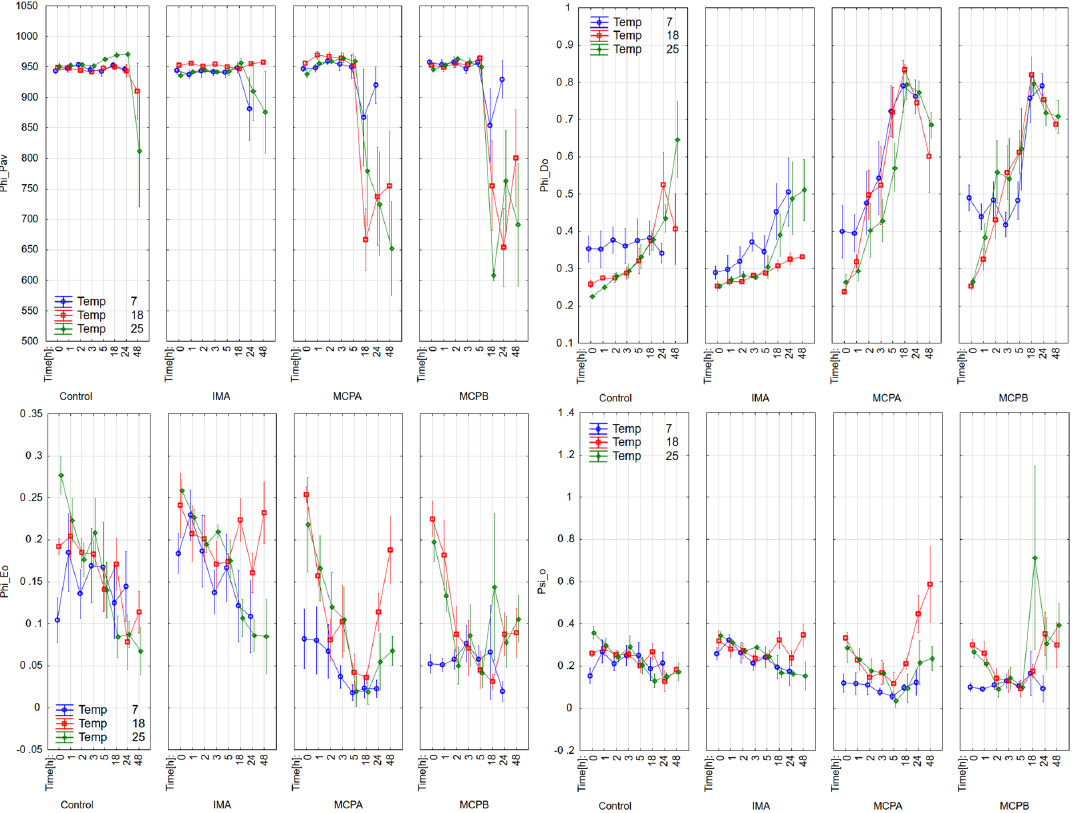
Figure 4. Effective quantum yields of particular photosynthetic processes in PSII (Phi_Pav, Phi_Do, Phi_Eo and Psi_Eo) as affected by MCPA, MCPB and IMA in G. orientalis cultivated at three different temperatures (7, 18 and 25 °C). Data points represent means of five replicates ± standard deviation. The replicates were five leaves, each on a different plant.